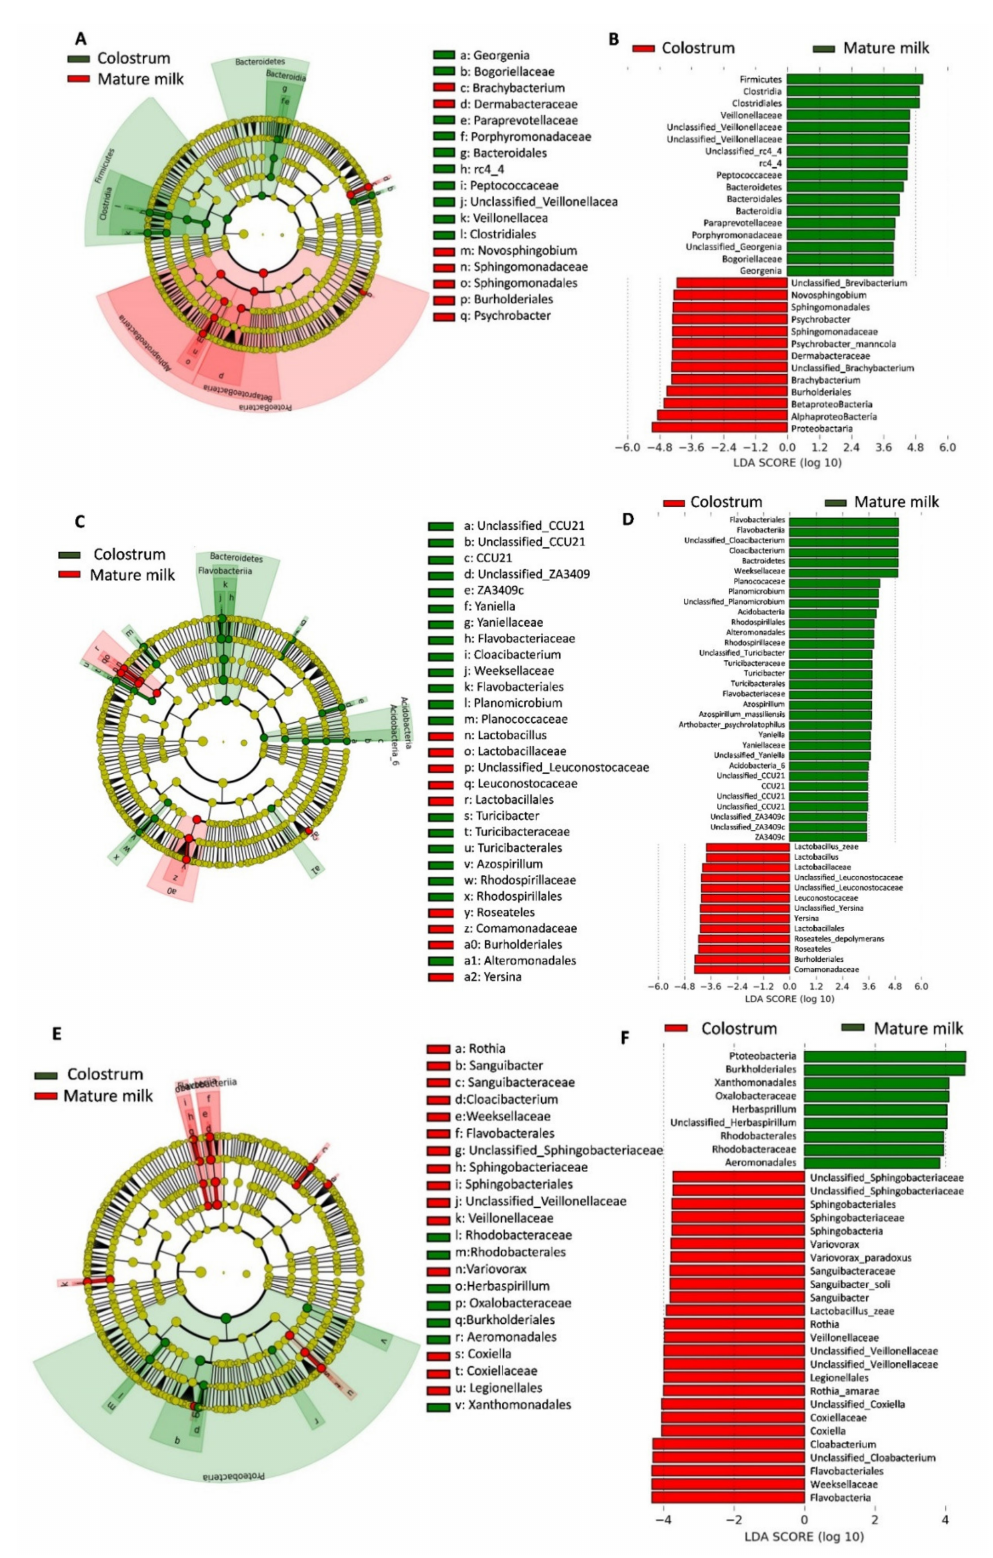
Figure 5. Linear discriminant analysis e ff ect size (LEfSe) analysis of dairy goat colostrum and mature milk microbiota taxonomic di ff erences from three di ff erent farms. Di ff erently abundant taxa